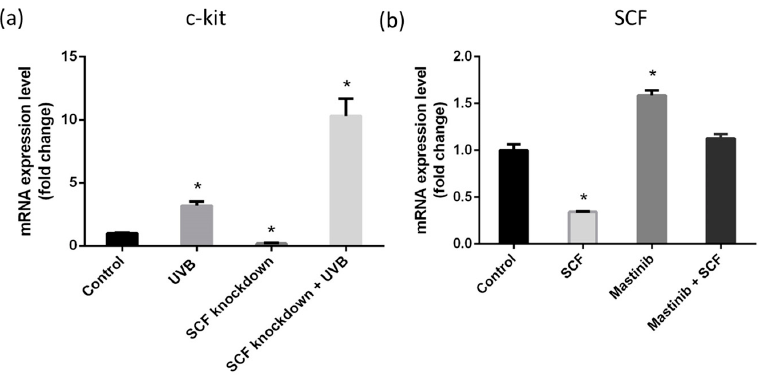
Figure 5. Autocrine of SCF on fibroblasts. ( a ) The expression of c-kit on fibroblast; ( b ) Fibroblasts treated with SCF 30 ng, mastinib 3 μ M, and both of mastinib and SCF. The data are presented as means ± SD; n = 3. * p < 0.015.